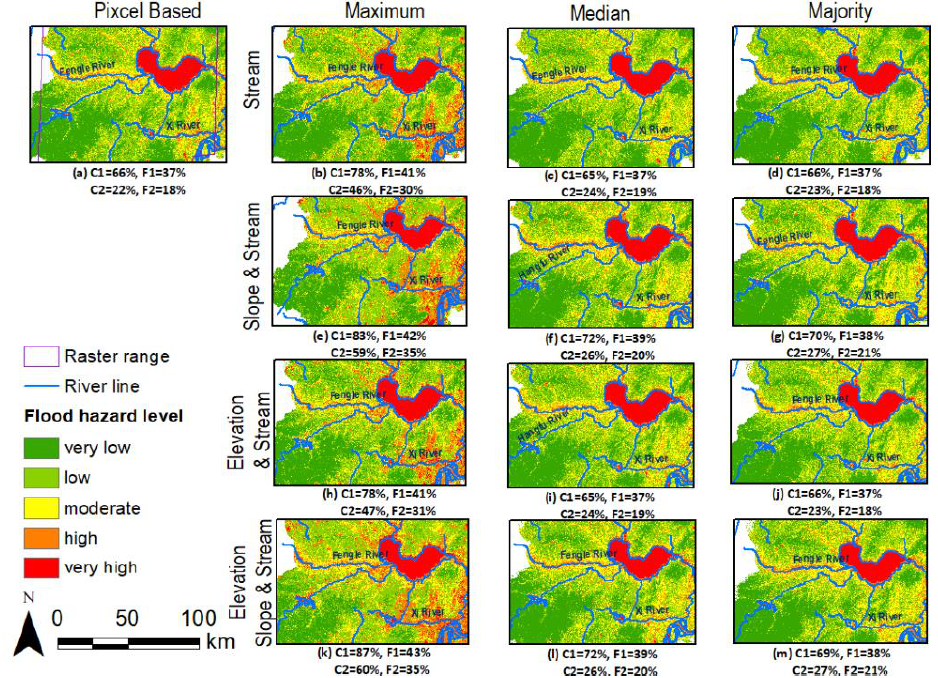
Figure 7. Flood hazard levels from pixel-based AHP ( a ), while ( b – m ) show flood hazard levels derived by WZSAHP-RC using different indicators and zonal statistics.